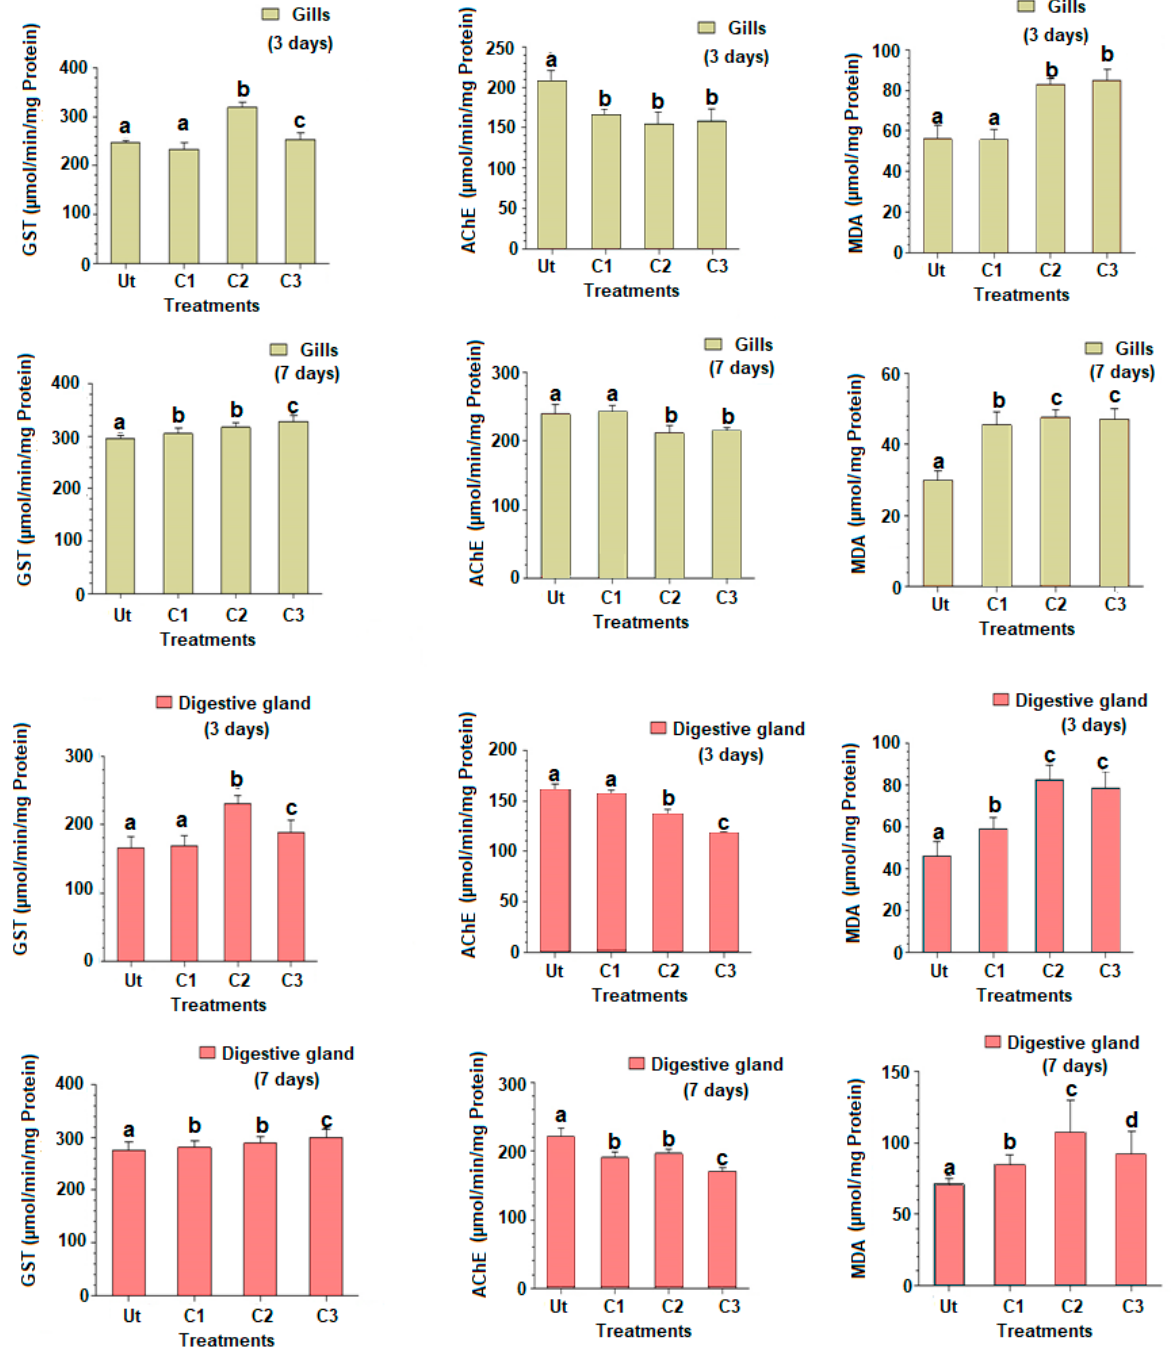
Figure 2. Gluthatione S -transferase (GST) and acetylcholinesterase (AChE) activities and malondialdehyde rate (MDA) in gills and digestive glands of the European clam Ruditapes decussatus after exposure to triclosan (C1 = 100 ng/L et C2 = 200 ng/L et C3 = 500 ng/L) during three and seven days in comparison to the untreated controls (Ut). Different letters (a, b, and c) above bars indicate significantly differences from controls represented by ‘a’ after multiple comparisons using Tukey’s HSD test.